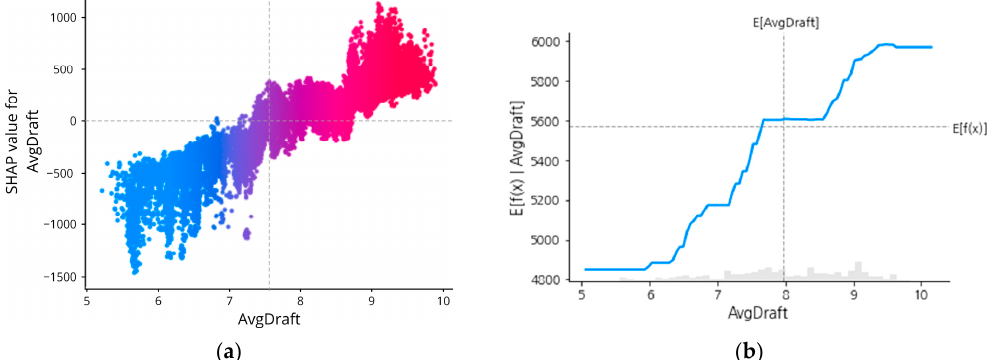
Figure 12. SHAP dependence plot ( a ) and partial dependence plot ( b ) of AvgDraft.